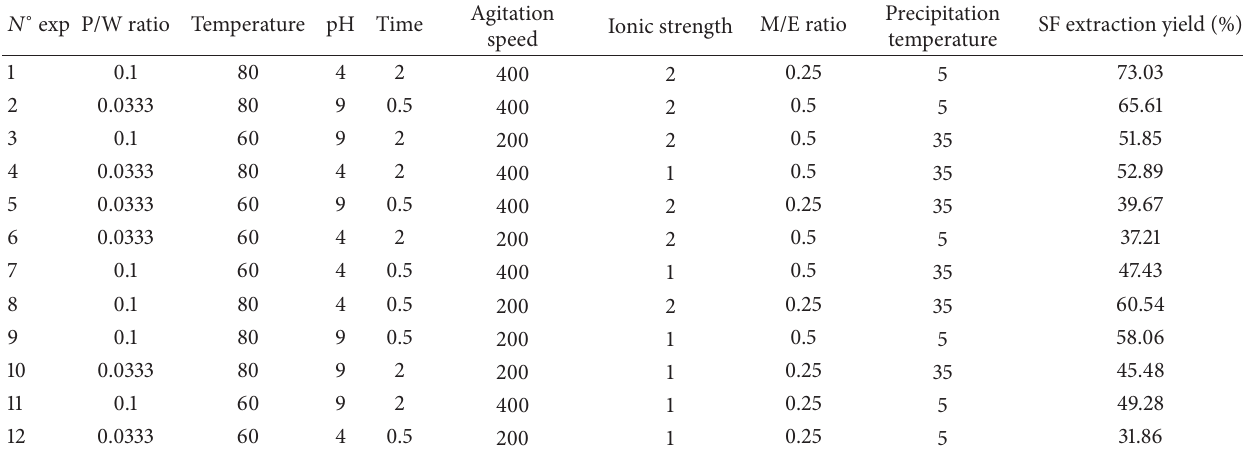
Table 5: Experimental conditions of Plackett-Burman design for soluble fibres extraction and the corresponding experimental responses. 𝑁 ∘ exp P/W ratio Temperature pH